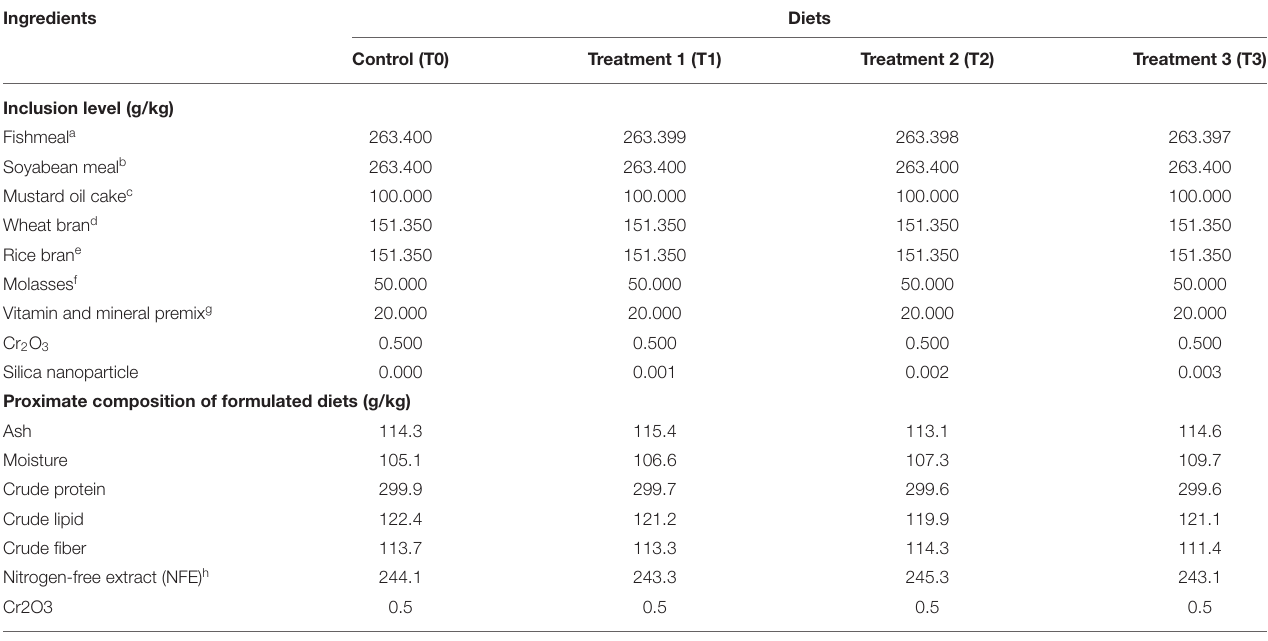
TABLE 1 | The inclusion level of main ingredients and proximate composition of the formulated diets.